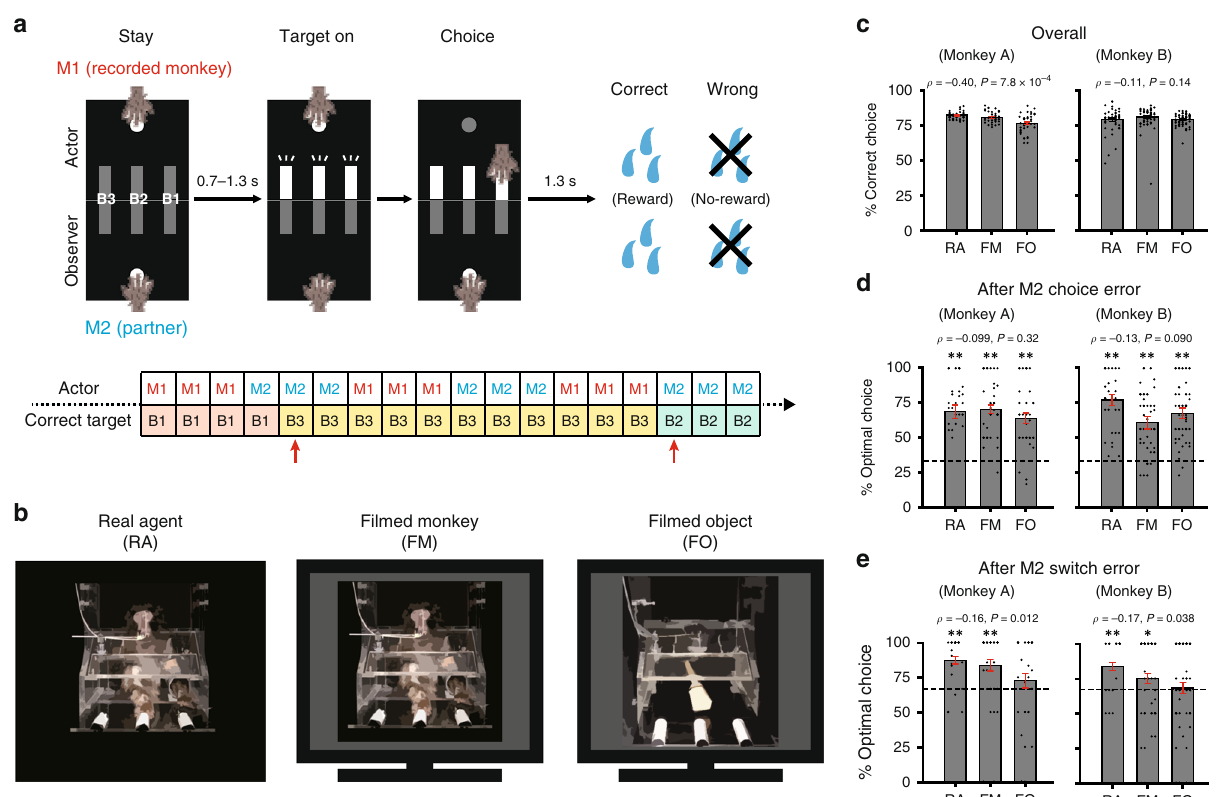
Fig. 1 Behavioral task and performance. a Event sequence in the role-reversal choice task. A single trial example is shown in which a recorded monkey (M1) was the actor and its partner (M2) was the observer (top). The correct target button (B1, B2, or B3) switched every 11 – 17 trials, and the actor and observer roles alternated every three trials (bottom). Red arrows indicate switch trials. b Three partner conditions. In all conditions, the partner ’ s action was observed from a frontal point of view. In the FO condition, a wooden stick made the choices. c Overall performance (percent correct choice). Mean ± s. e.m. [ n = 44 (RA), 39 (FM), 40 (FO) sessions for monkey A; n = 57 (RA), 67 (FM), 67 (FO) sessions for monkey B]. ρ and P values, Spearman correlation test. Source data are provided as a Source Data fi le. d Performance (percent optimal choice) after partner choice error. Mean ± s.e.m. [ n = 44 (RA), 39 (FM), 40 (FO) sessions for monkey A; n = 57 (RA), 67 (FM), 67 (FO) sessions for monkey B]. ρ and P values, Spearman correlation test (two-sided). Dotted lines indicate the chance level (33.3%; see Methods). Asterisks indicate signi fi cant differences from chance (** P < 0.01, Student ’ s t test,